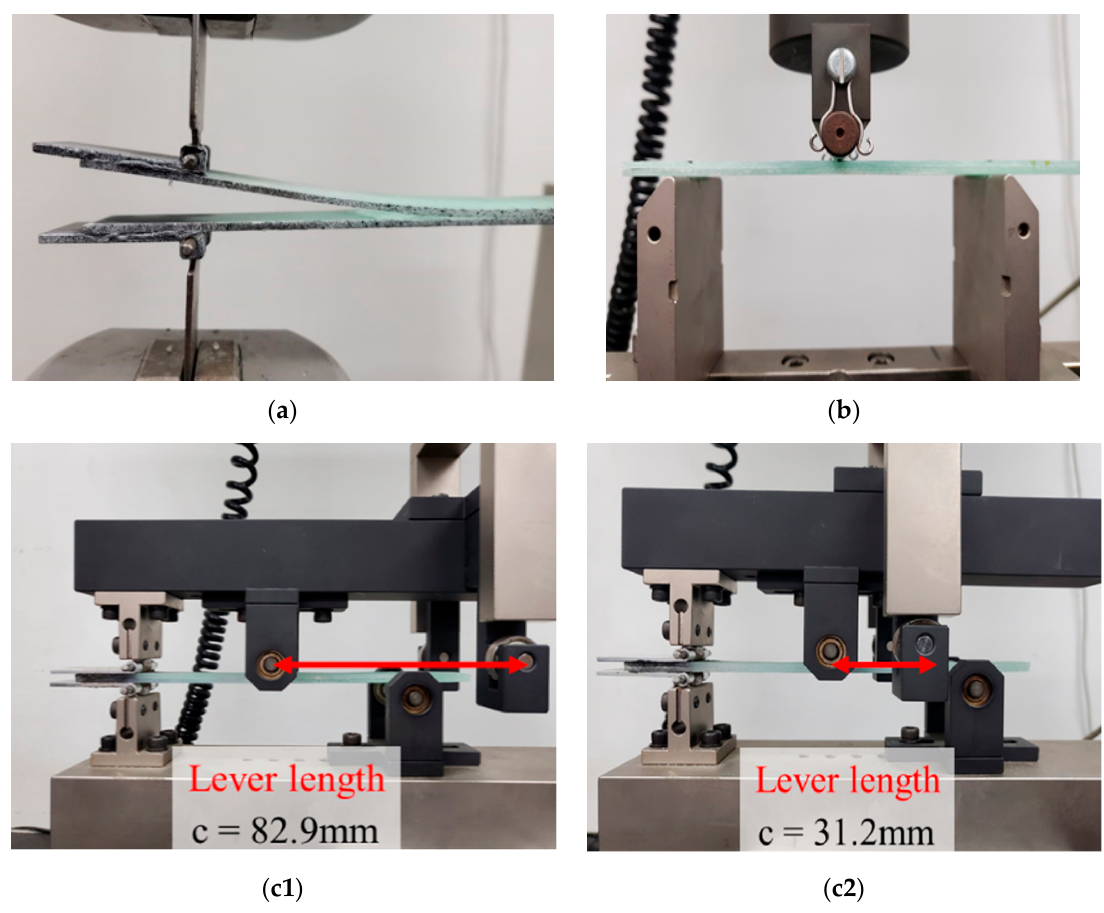
Figure 2. Fracture toughness test case: ( a ) Mode I, ( b ) Mode II, and ( c ) Mixed-mode. The Mixed-mode test combines Mode I and Mode II to acquire the material factor that indicates the nonlinear behavior of crack growth [22,23]. To choose the lever length, c, which is the main condition for controlling the mixed-load mode, lever lengths of 82.9 mm and 31.2 mm were chosen for the test based on the mode mixture ratio, as shown in Figure 2c. In addition, the displacement was controlled at a speed of 0.8 mm/min until the final length of the crack growth reached 8 mm, and three tests were conducted for each lever length. At this time, to eliminate inhomogeneity in the adhesive joint, the test was performed at a speed of 0.5 mm/min until the crack growth reached 5 mm before unloading the specimen. Through these tests, the data for displacement, load, and crack growth length were obtained. The displacement and load data were obtained at a sampling rate of 10 Hz. In addition, the length of the crack growth was measured using a crack measurement camera, as shown in Figure 3, to acquire precise values, and the crack length was calculated using the Mercury RT software